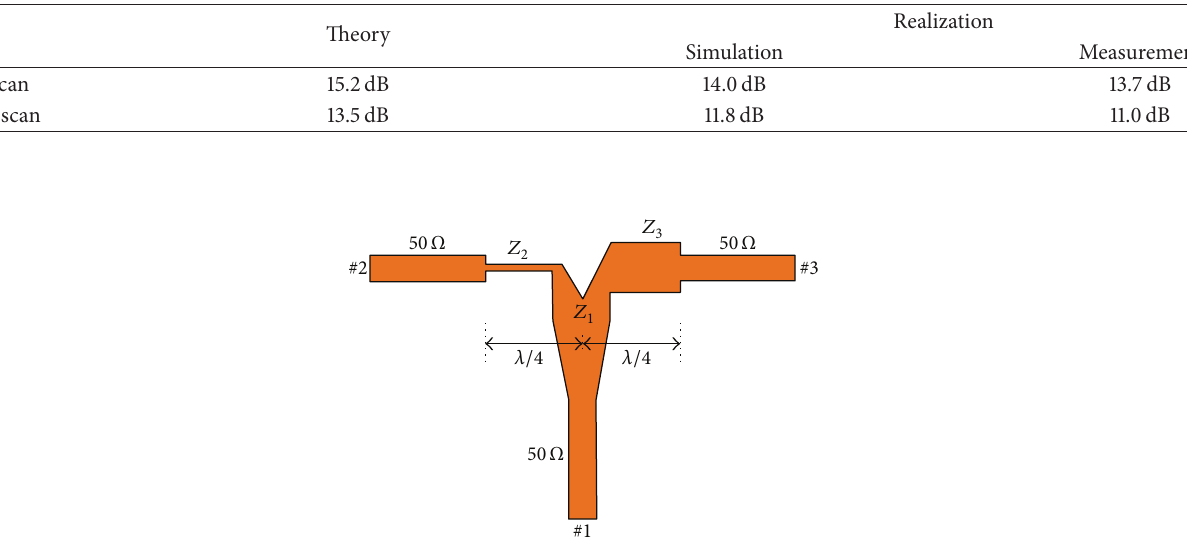
Figure 7: Geometry of unequal T-junction power